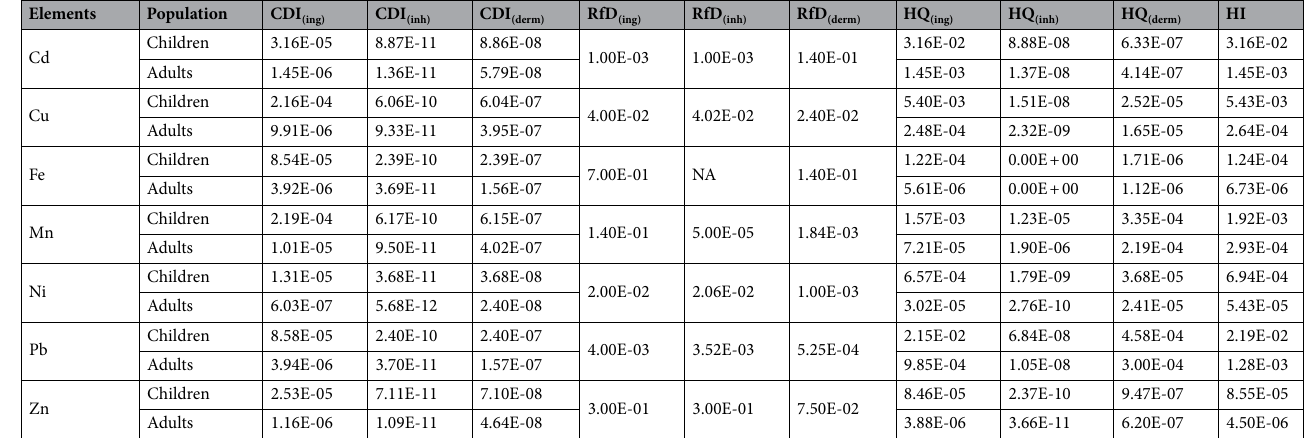
Table 5. Non-carcinogenic health risk assessment of potentially toxic elements in soils around Oke-Tage refuse dumpsite. CDI = chronic daily intake, RfD = reference dose, HQ = hazard quotient, HI = hazard index, ing = ingestion, inh = inhalation, derm =